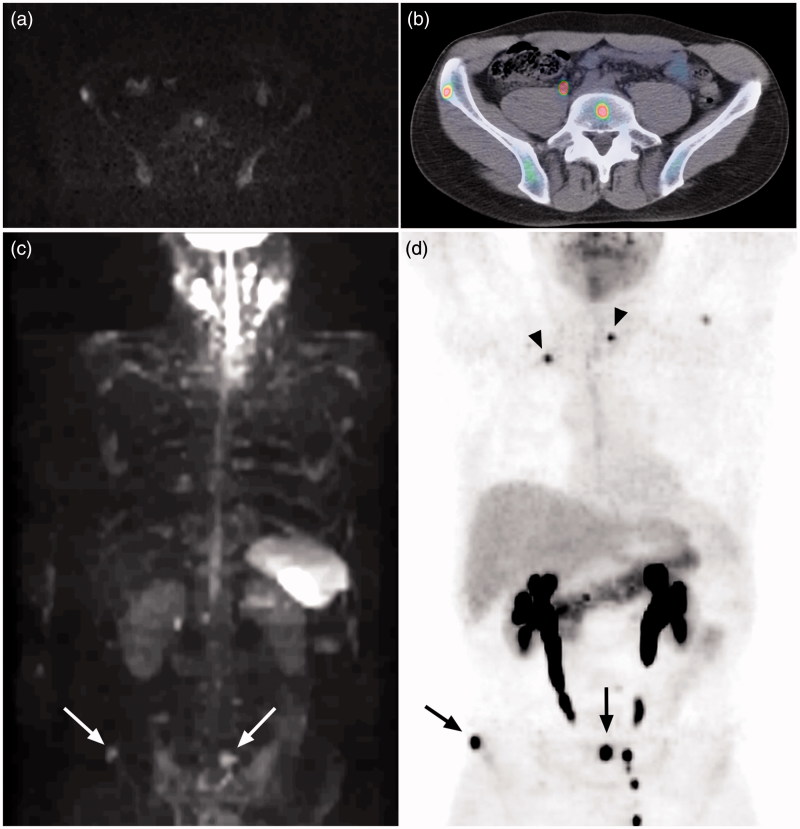
Bone marrow metastases in the lumbar spine and pelvis clearly visualized by both axial diffusion-weighted MRI (a) and 5-HTP PET/CT (b). The lesions in (a) and (b) are indicated (arrows) in MIP-images of diffusion-weighted MRI (c) and 5-HTP PET (d) in the same patient. The lymph node metastasis in thorax and bone marrow metastasis in vertebra Th II (arrow heads) are not detected with MRI (c), but clearly seen with PET (d). Hyperintense normal CNS, salivary glands, spleen, and lymph nodes are also seen in (c). Normal excretion of metabolites to the urinary tract is seen in (b) and (d).